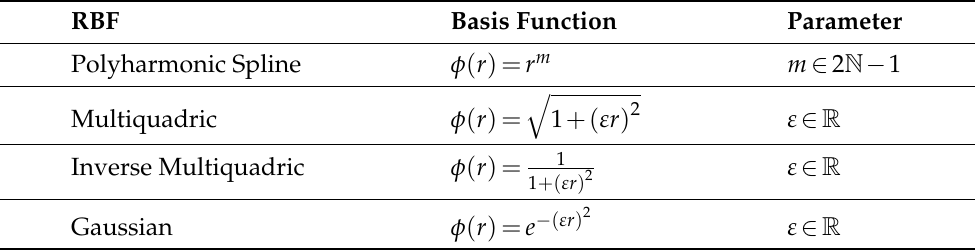
Table 1. Example